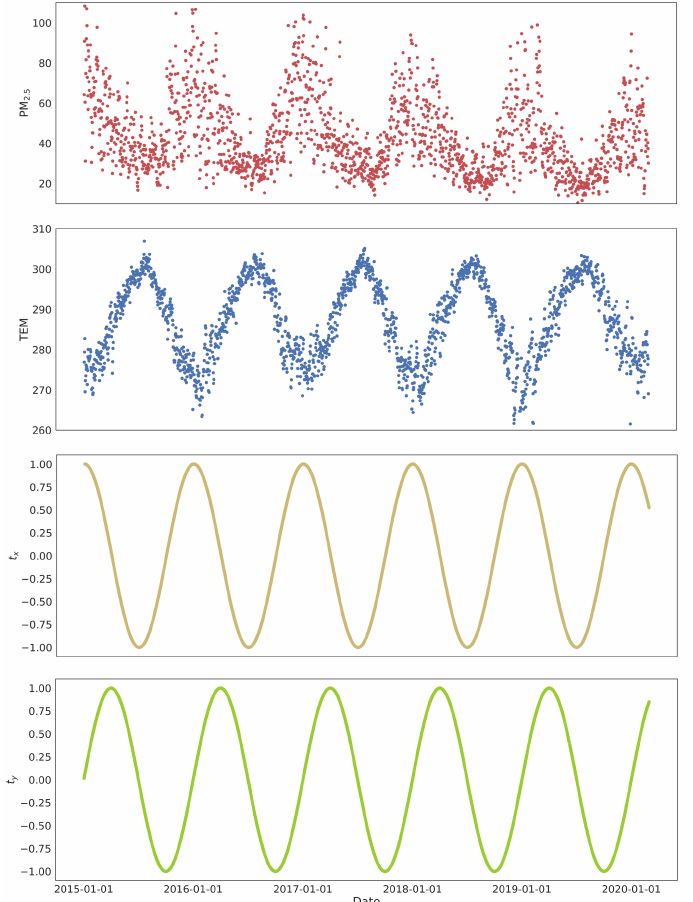
Figure 10. Scatter plot of the daily average PM 2.5 concentrations ( µ g m − 3 ), temperature (TEM), t x and t y of all observation sites from 2015 to